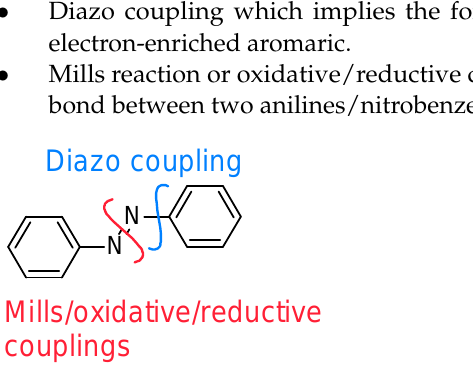
Figure 3. Ways of azobenzene formation.